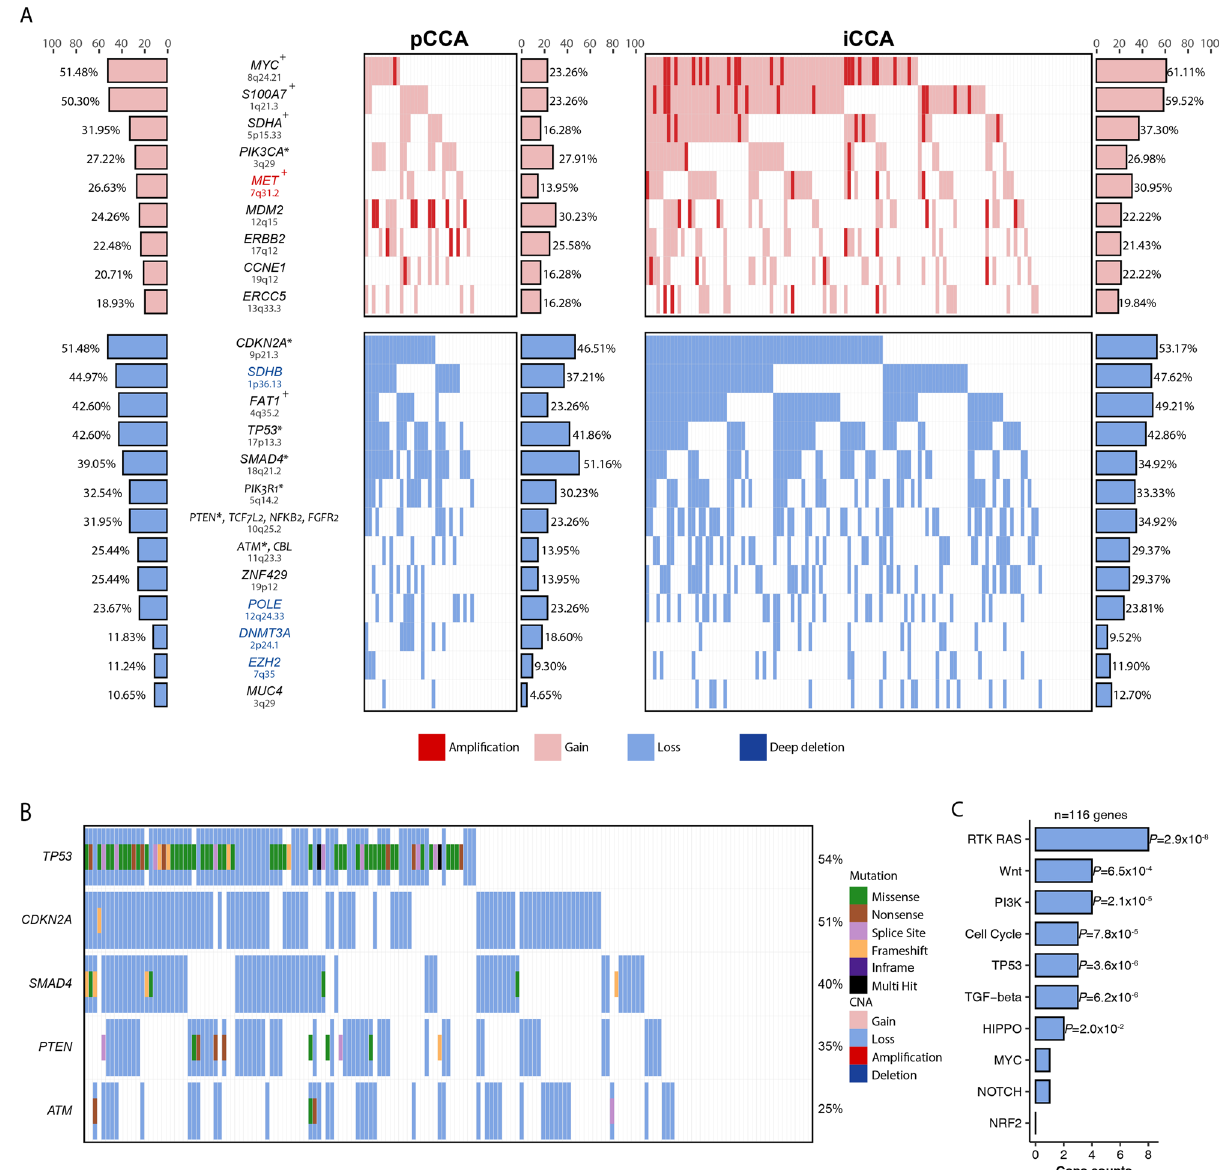
Fig. 3 Frequently altered focal CNA regions and characteristics of mutation-driver and CNA-driver genes. A Shows 22 curated frequently-altered focal CNA regions involving cancer-related regions. Each column represents one of the CCA patients and each row represents a focal region. The bar chart at the left panel indicates the overall CNA rate in all CCAs. The right panel is the CNA spectrum and rate for pCCAs and iCCAs, respectively. The top panel represents ampli fi cation and the bottom represents deletion regions. Region names in red and blue indicate the novel alterations the plus sign following the gene symbol indicates a signi fi cant alteration rate difference between pCCAs and iCCAs. Asterisk means the genes in focal region were also identi fi ed in SMGs. B The co-occurrence of copy number losses and mutations of relevant tumor suppressor genes. C Pathway enrichment results of mutation-driver and CNA- driver genes in TCGA pancancer ten pathways, P value of hypergeometric test. * P < 0.05; ** P < 0.01, *** P <